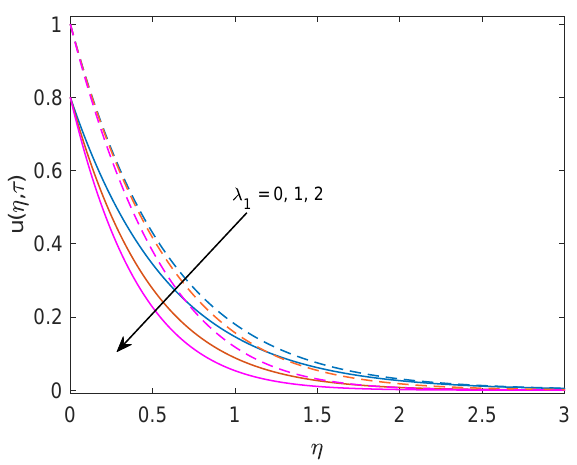
Figure 6. Effect of different values of λ 1 .